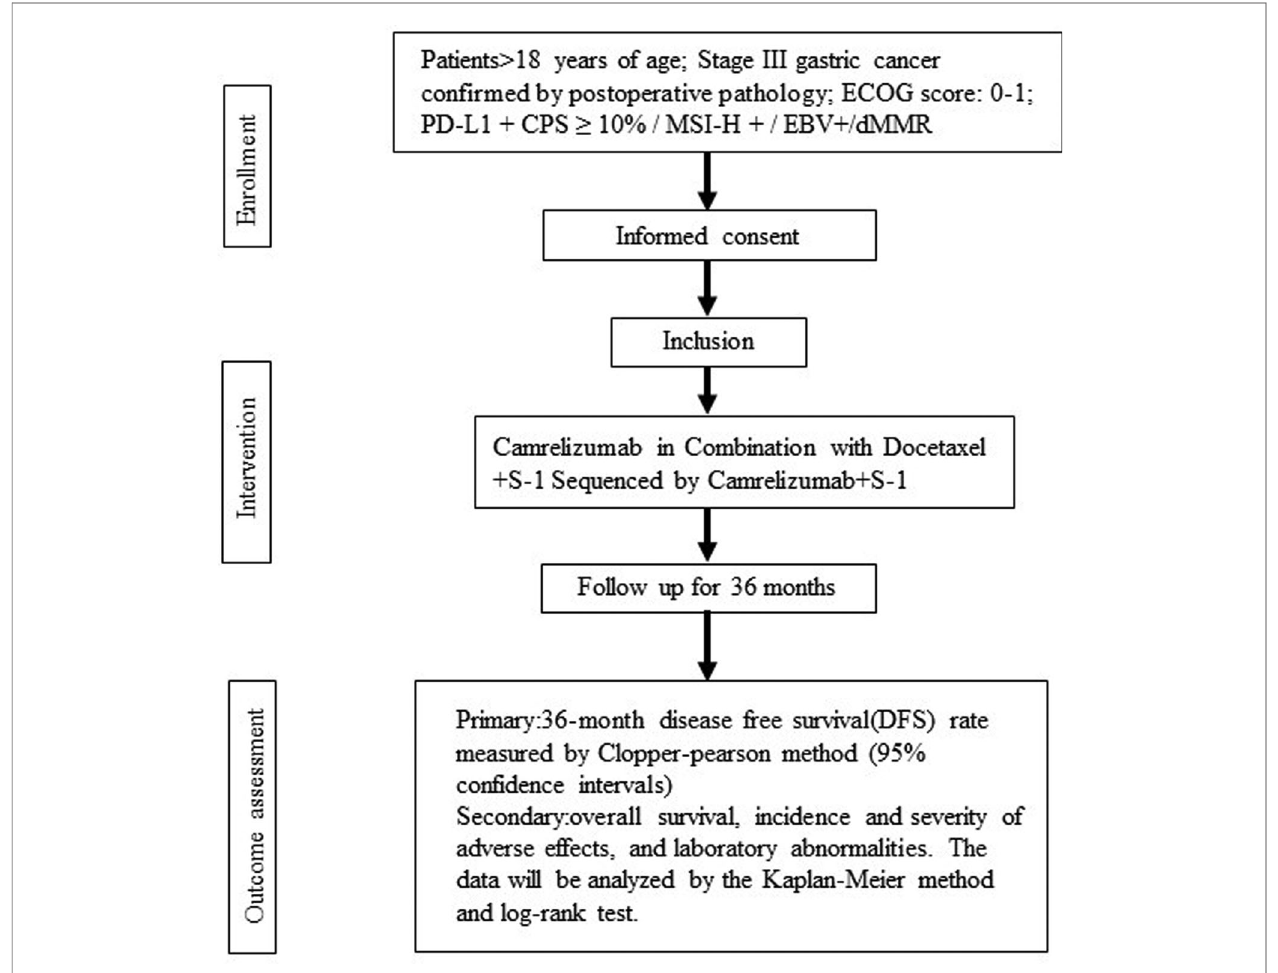
FIGURE 1 | Flowchart summarizing the trial procedure. Stage III gastric cancer participants in Camrelizumab in Combination with Docetaxel+S-1 Sequenced by Camrelizumab+S-1 for